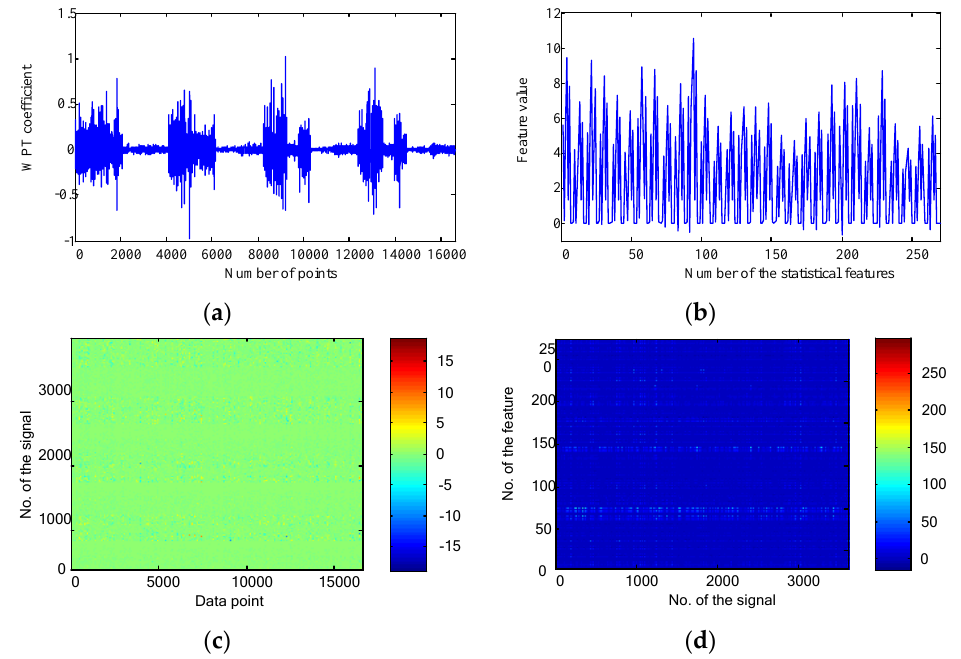
Figure 8. Time-frequency domain features for the gearbox fault diagnosis: ( a ) WPT representation of the first signal; ( b ) time-frequency domain statistical features of the first signal; ( c ) time-frequency domain representations of all the collected 3600 signals; and ( d ) time-frequency domain statistical features of all the collected 3600 signals.